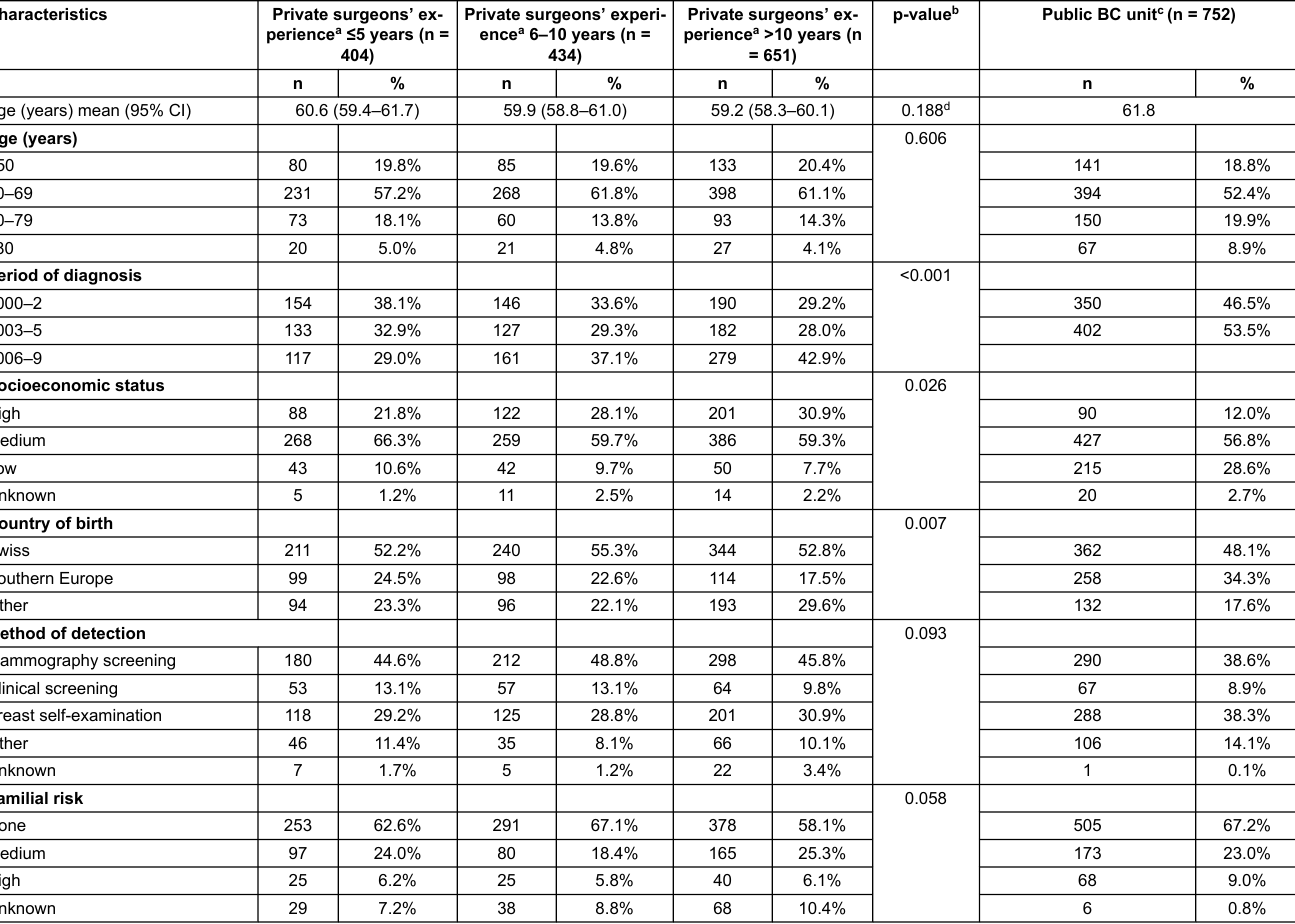
Table 1: Characteristics of breast cancer patients according to the surgeon's experience (Geneva Cancer Registry 2000–2009).